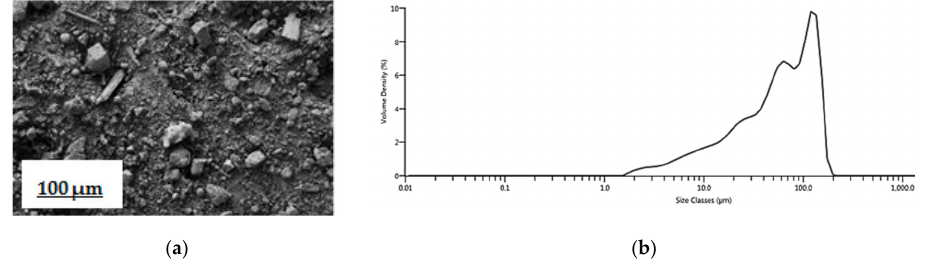
Figure 2. ( a ) FESEM image of untreated fly ash, 250×, the bar indicates 100 μ m length.; ( b ) particle size distribution of fly ash.